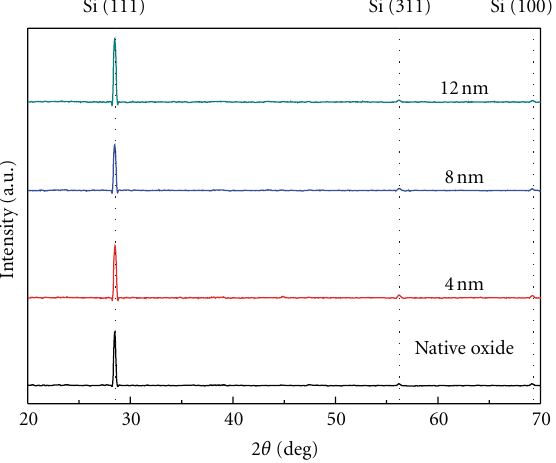
Figure 2: Images of pc-Si film after Al etching and ultrasonic vibration polishing.